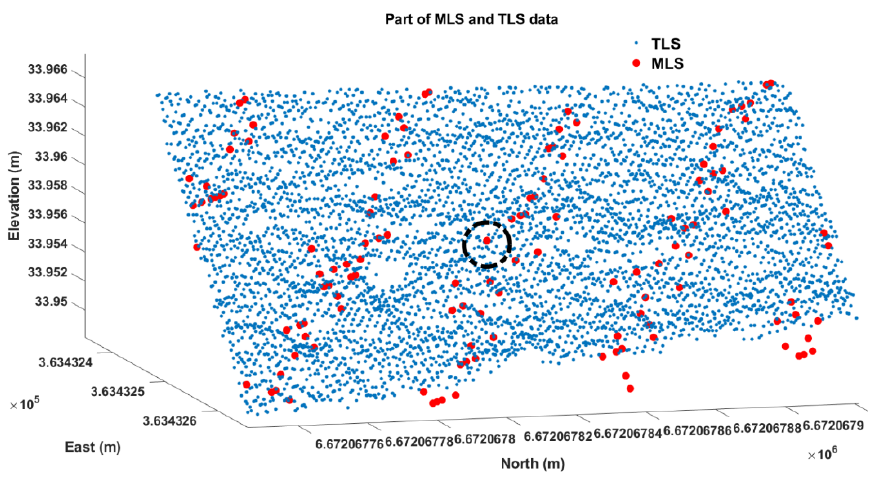
Figure 8. A piece of road surface from the MLS (red dots) and TLS (blue dots) data. To generate a high-accuracy rut depth reference, down-sampling of the TLS data was performed to generate road profiles at the locations of the profiles generated by the MLS. The down-sampling was conducted by averaging the neighboring TLS data around the MLS data. More specifically, at the position of each MLS point, the surrounding TLS points were selected within a horizontal distance of 5 mm (black circle in Figure 8). The z coordinates of the down-sampled TLS points were the average elevation values within the neighborhood, and the horizontal coordinates were equal to those of the corresponding MLS data. In this way, the rut depth estimation with TLS data and MLS data can be performed at exactly same locations, which help avoid possible variation errors introduced by location. The down-sampling matches TLS data with MLS data to guarantee accurate TLS reference (Figure